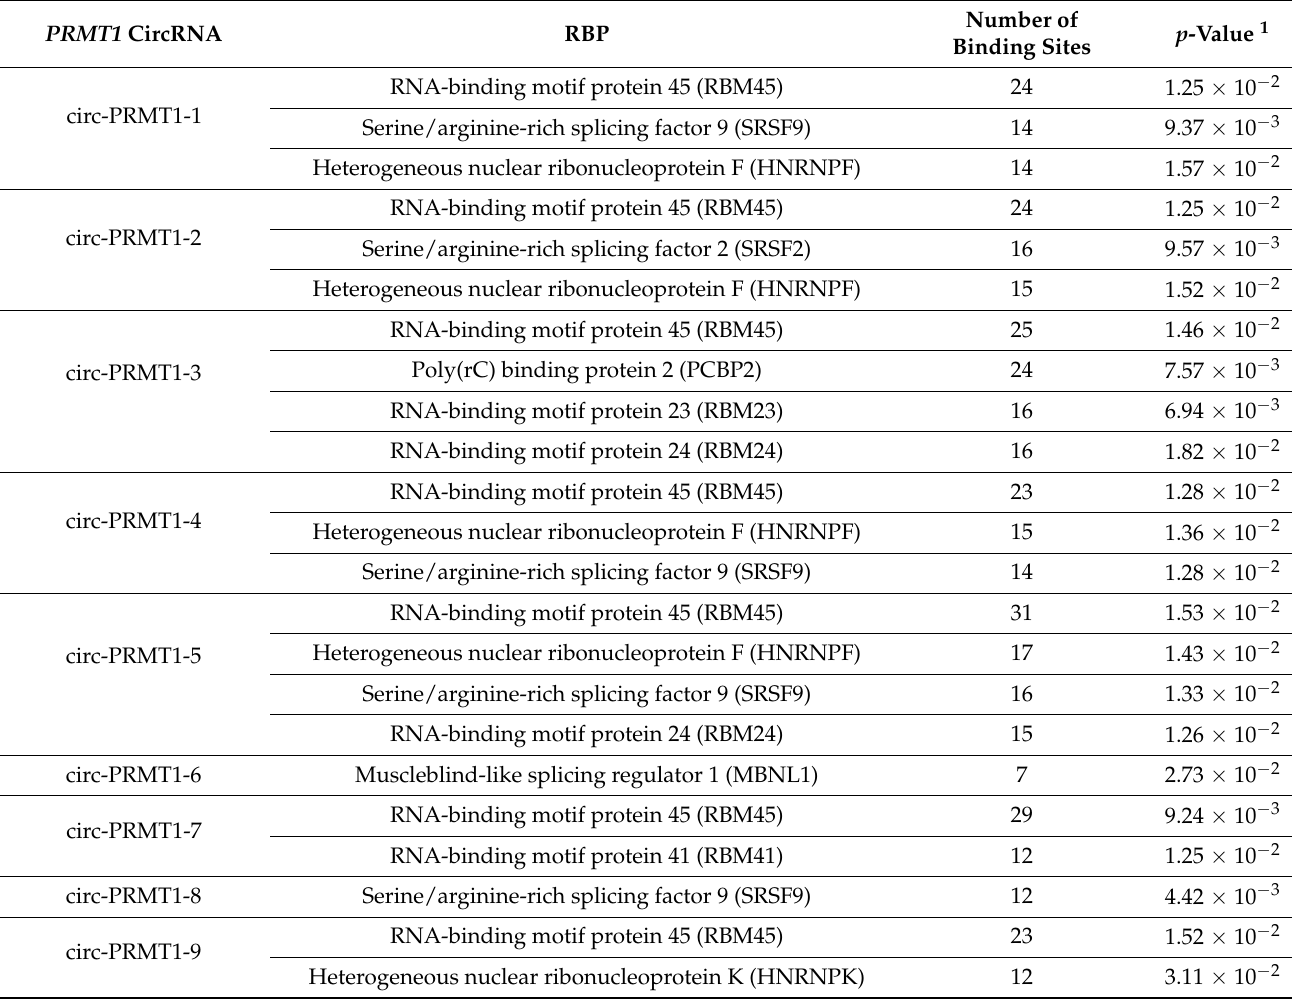
Table 3. The RNA-binding proteins (RBPs) that are predicted to bind to the novel PRMT1 circRNAs, based on the number of binding sites and a high probability score, as resulting from the RBPmap